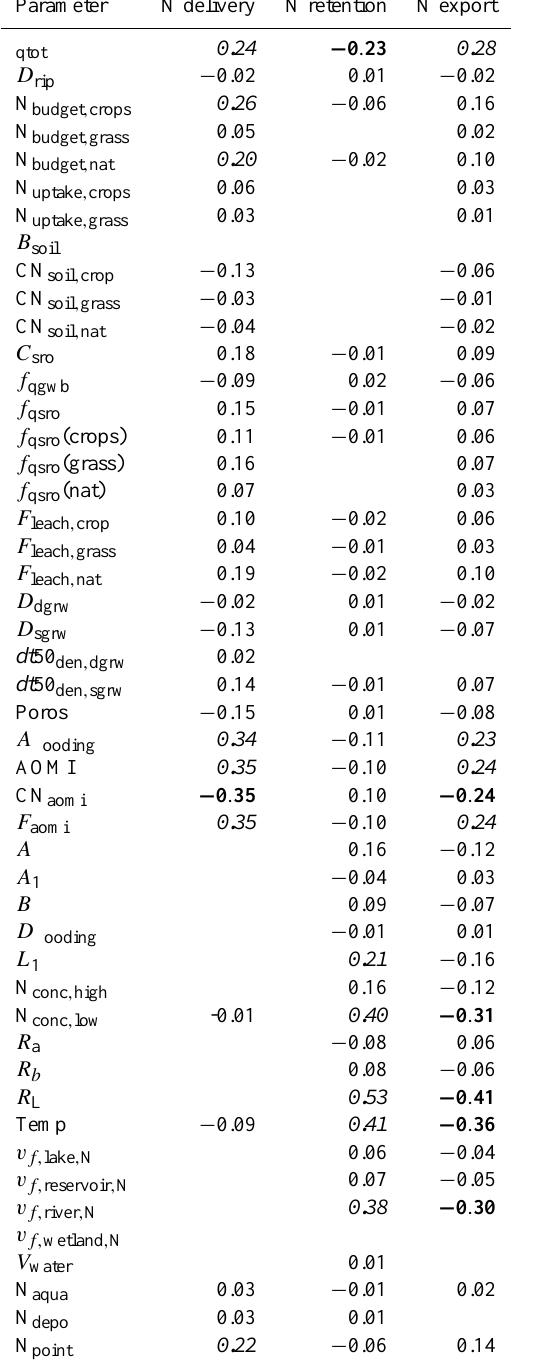
Table 6. Standardized regression coefficient (SRC) ∗ representing the relative sensitivity of P delivery, P retention and river P export representing global model results (columns) for the year 2000 to variation in 34